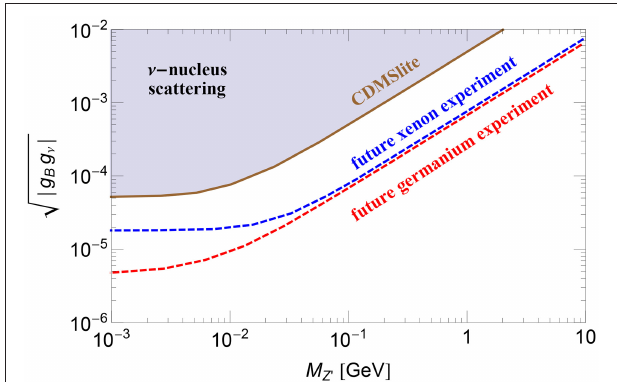
FIGURE 9 | Approximate 90 % C.L. bounds on the product of couplings of neutrinos and quarks to Z ′ from solar-neutrino nuclear recoils in CDMSlite and optimistic projections for second-generation Xenon (e.g., LUX–ZEPLIN) and Germanium experiments (e.g., SuperCDMS SNOLAB), adapted from Cerdeno et al. [ 184]. Plot taken from Farzan and Heeck [25] and reproduced with the permission of the American Physical